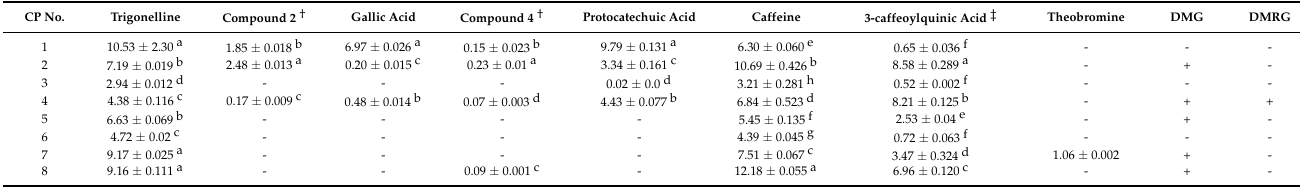
Table 2. Quantification and distribution of the 10 CP compounds (mg/g).